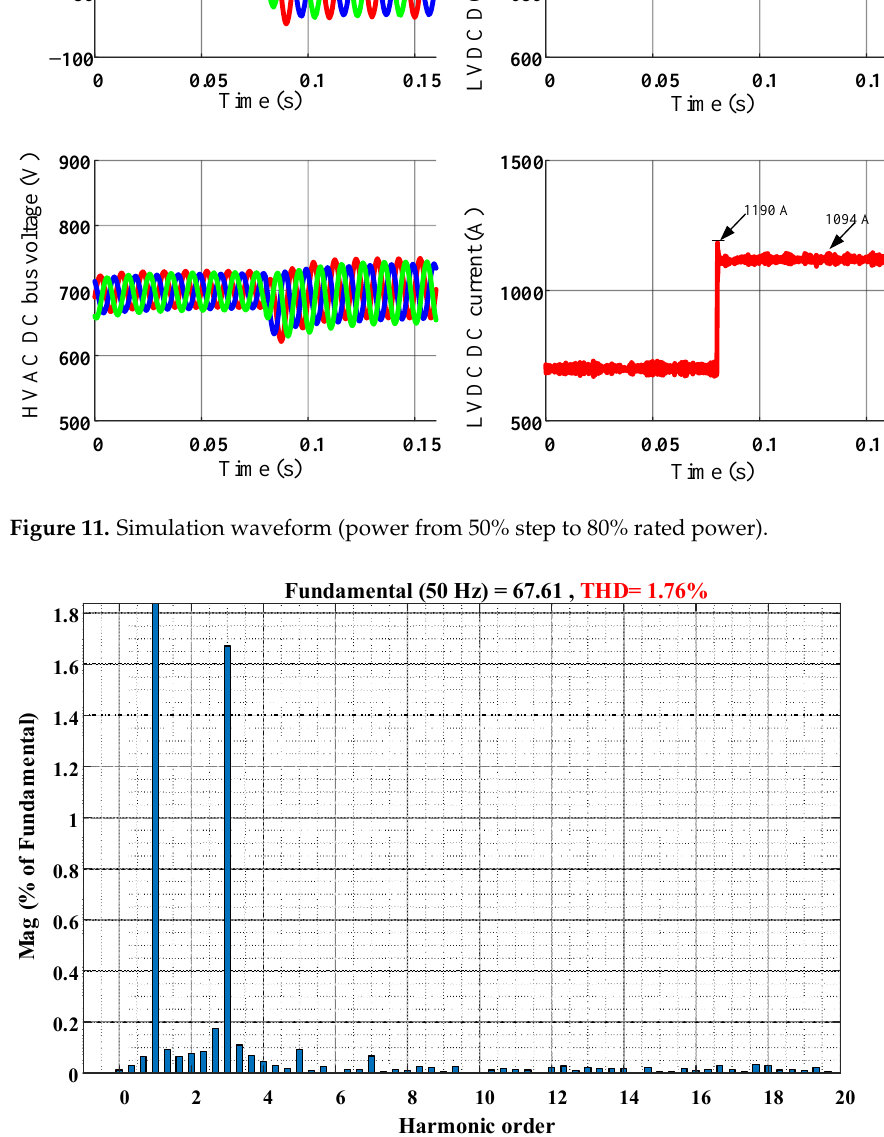
Figure 12. HVAC grid current THDi (80% of rated power). Figure 13 shows the simulation results of grid current, HVDC DC bus voltage, LVDC DC bus voltage and LVDC DC current under the condition of battery power step from 80% to 100%. It can be seen that the dynamic response process of the HVAC AC side is less than 20 ms with no overshoot. The peak value of transient overvoltage at the LVDC side is about 750 V and overshoot is about 0.01%, and the peak value of transient overcurrent at the LVDC side is about 1455 A and overshoot is about 0.08%, which is within the allowable range. Under the condition of 50% rated power, the output current THDi is 2.86%, as shown in Figure